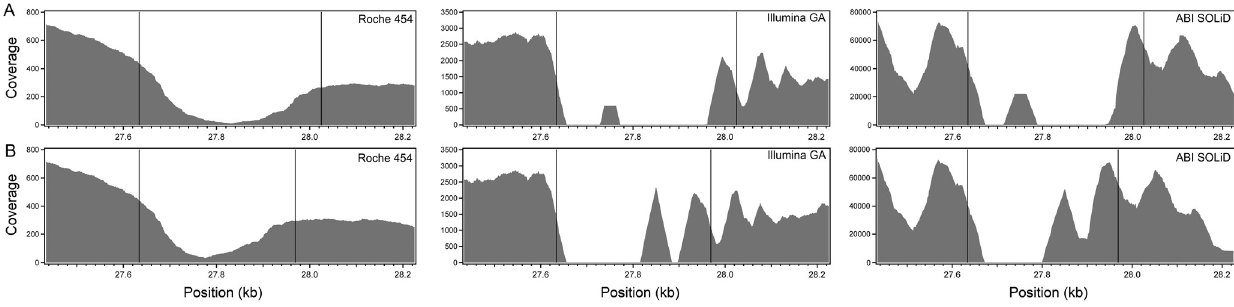
Figure 5. Coverage of the PRPF31 intronic VNTR. Values shown are relative to the mapping of the original ref_seq entry containing 7 repeats (A) or of the experimentally-determined sequence containing 6 repeats (B). Untrimmed reads are represented here because they produced the best alignment to this repetitive element. Vertical lines show the boundaries of the VNTR.